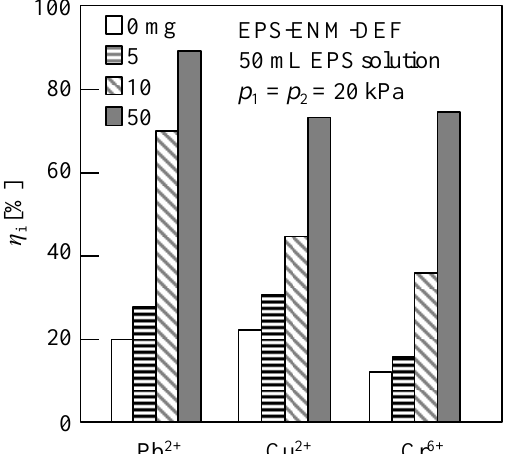
Figure 10. Removal efficiency ( η i ) of the heavy-metal ions (HMIs) via dead-end filtration using the ENM-14 with an EPS filter cake on the surface (EPS–ENM–DEF). The evaluated data were obtained for the cumulative filtrate volume per unit membrane area, v = 9 cm. First stage: concentration and recovery filtration of 0, 0.1, 0.2, and 1.0 g/L EPS solutions (50 mL) at p 1 = 20 kPa to give EPS filter cakes with masses of 0, 5, 10, and 50 mg, respectively. Second stage: filtration of 10 μM solutions (180 mL) of the desired HIM (Pb 2+ , Cu 2+ , or Cr 6+ , pH 6.2–6.7) at p 2 = 20 kPa.